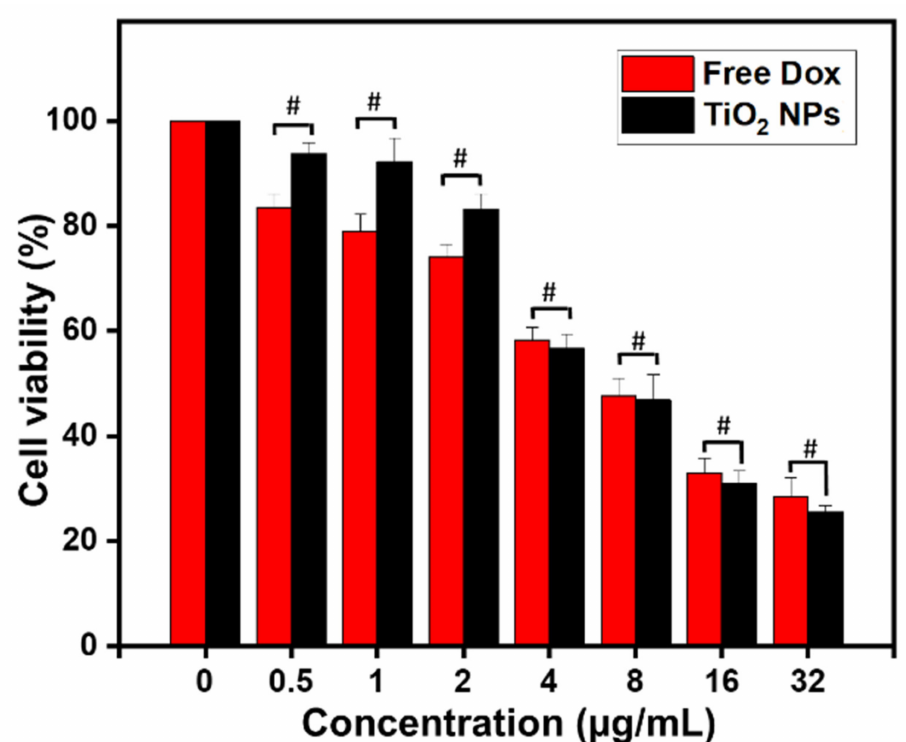
Figure 5. Relative viability of 4T1 cells after treatment for 24 h (at 37 ◦ C) with the indicated concen- tration of biosynthesized TiO 2 NPs. Free DOX at the same indicated concentrations was used as PC. Data are expressed as mean ± SD. # P >